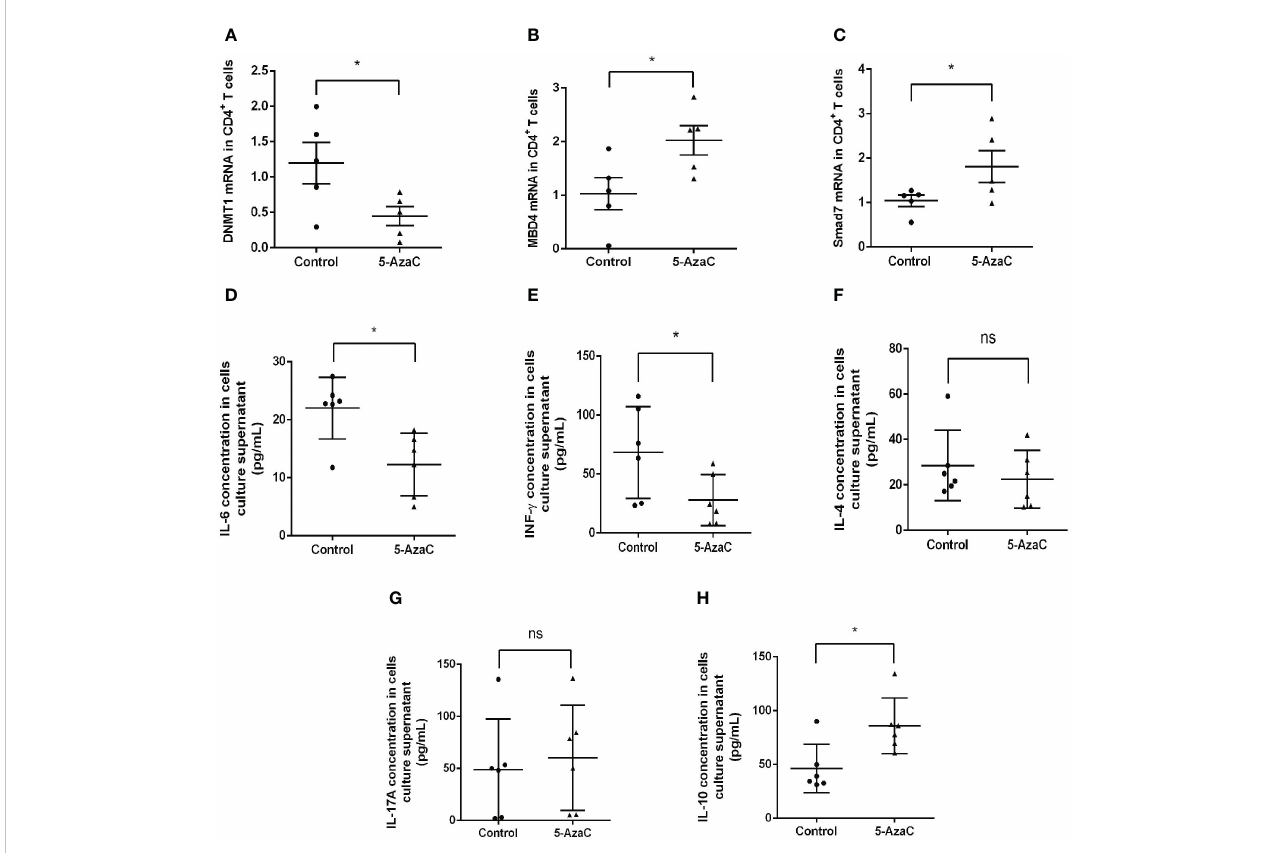
FIGURE 7 In-vitro effects of 5-AzaC on expression of DNMT1, MBD4, Smad7 mRNA and T cell cytokines in CD4 + T cells from RA patients by real-time PCR. The methylation effects were assessed in CD4 + T cells after stimulation with PHA and IL-2 in the presence or of 5-AzaC (2 m M). (A) The DNMT1 mRNA. (B) The MBD4 mRNA. (C) The Smad7 mRNA. (D – H) ELISA for IL-6, INF- g , IL-4, IL-17A, and IL-10. Each dot represents one individual and data are mean ± SD. * P < 0.05. ns, not signi fi